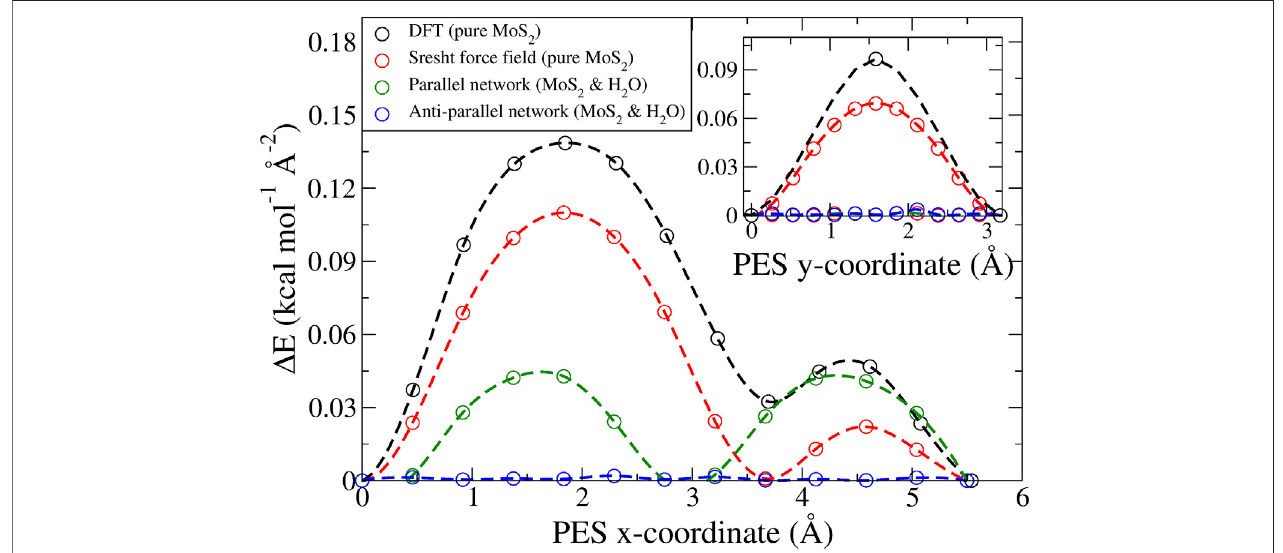
FIGURE1| Staticpotentialenergysurfacescalculatedperareaforthelong(inset:short)diagonalofthehexagonalunitcell.Fourdifferentcasesareconsidered:i)in black,pureMoS 2 obtained via DFT(Levitaetal.,2014),ii)inred,pureMoS 2 obtainedwiththeforce fi eldemployedinthisstudy(Sreshtetal.,2017),iii)ingreen,MoS 2 and an ideal, parallel water network via MD, and iv) inblue, MoS 2 and an ideal, antiparallel waternetwork via MD. Thedashed lines are obtained via akima spline interpolation and serve merely as a guide to the eyes.